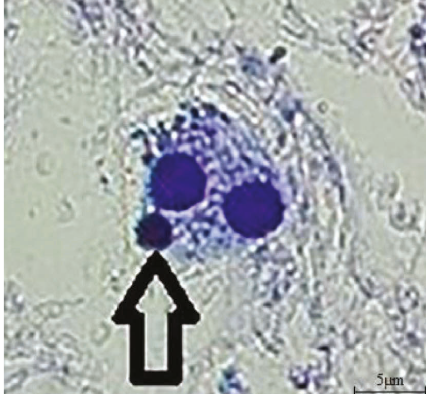
Figure 1: Giemsa stained, binucleated human lymphocyte cells; haloperidol-treated group at a concentration of 100ng/ml (400X); the micronucleus is demonstrated with an arrow. Scale bar: 5 µ m.